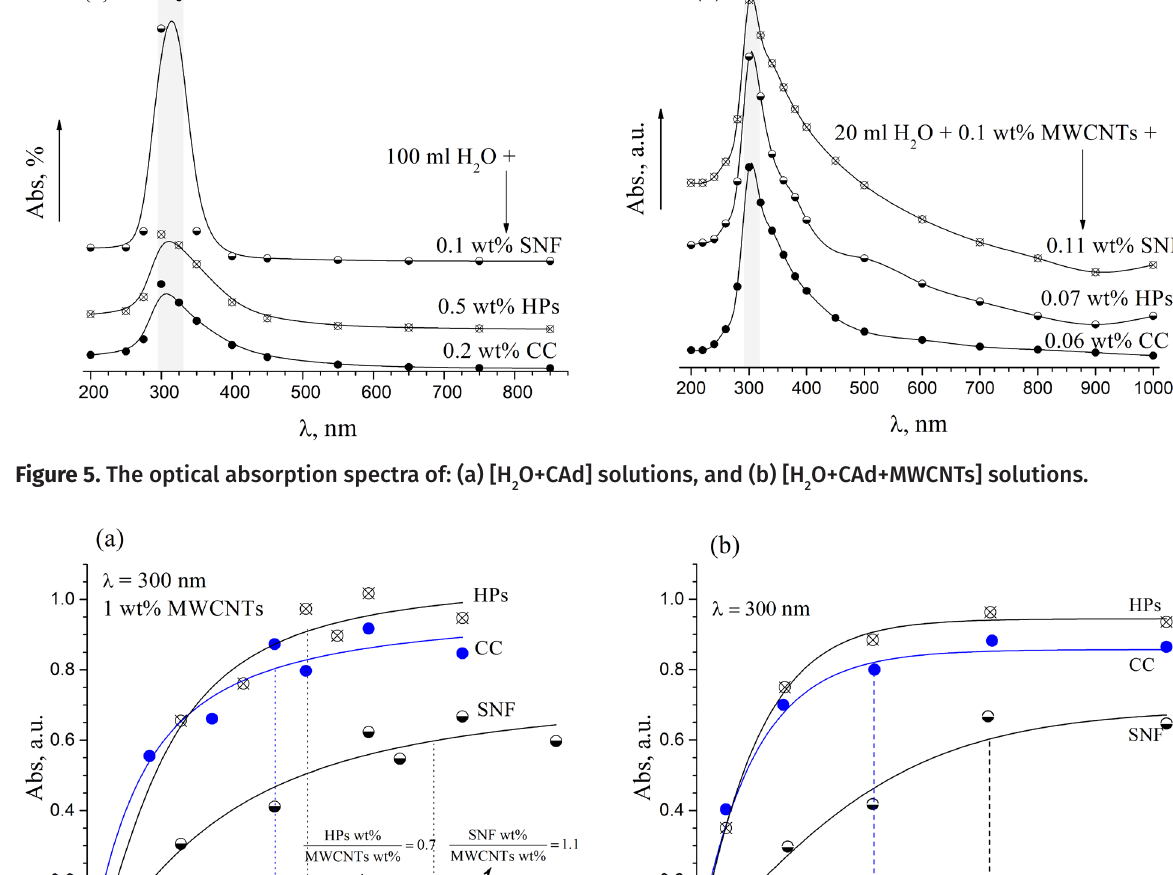
Figure 6. (a) The optimal values of the CAd/MWCNTs loading ratio. (b) The optimal amount of energy supplied to the [H O+CAd+MWCNTs] suspensions when the CAd/MWCNTs ratio was constant and equal to the optimal value 2 (Figure